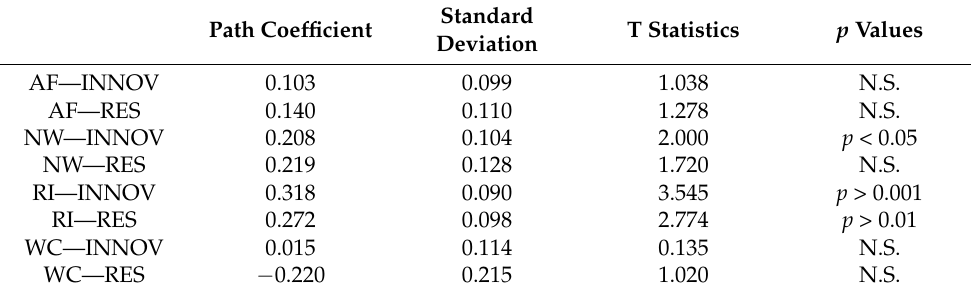
Table 2. Structural model